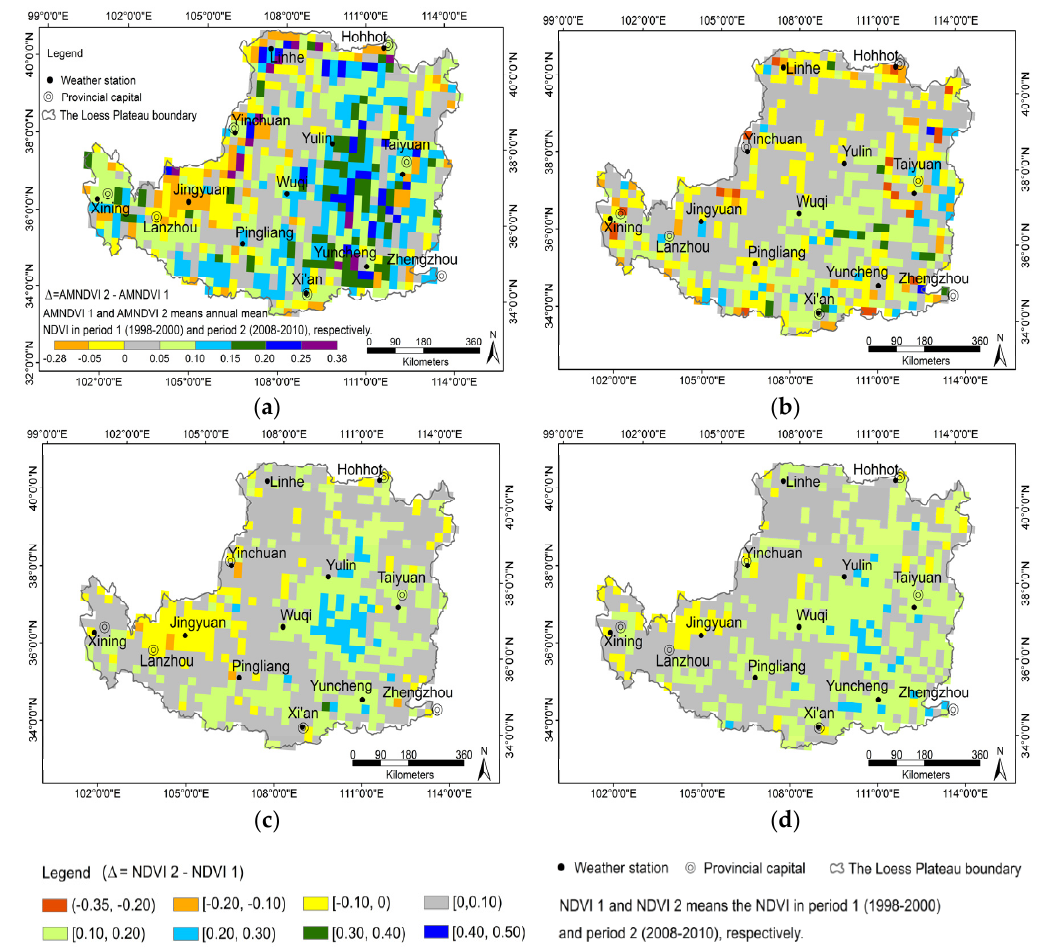
Figure 3. The spatial differences of mean annual NDVI ( a ), the NDVI for the three seasons (spring ( b ); summer ( c ); and autumn ( d )) between the two chosen periods on the Loess Plateau.